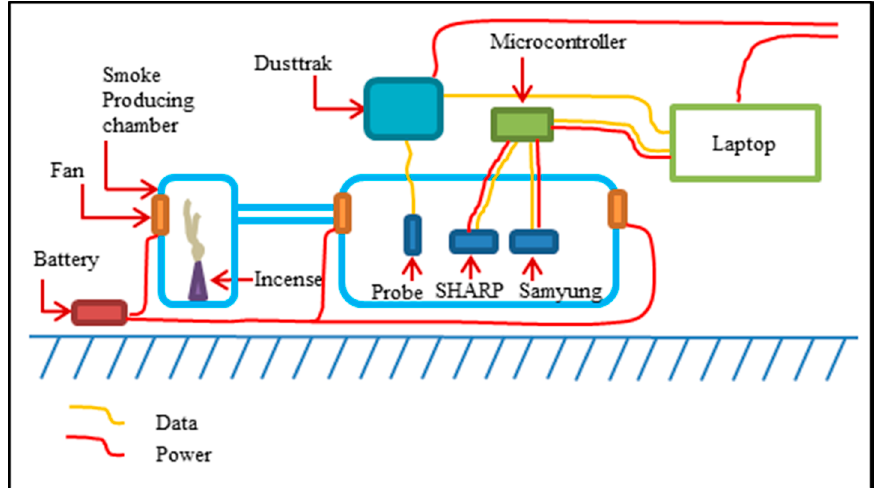
Figure 6. Gas chamber for sensor testing and